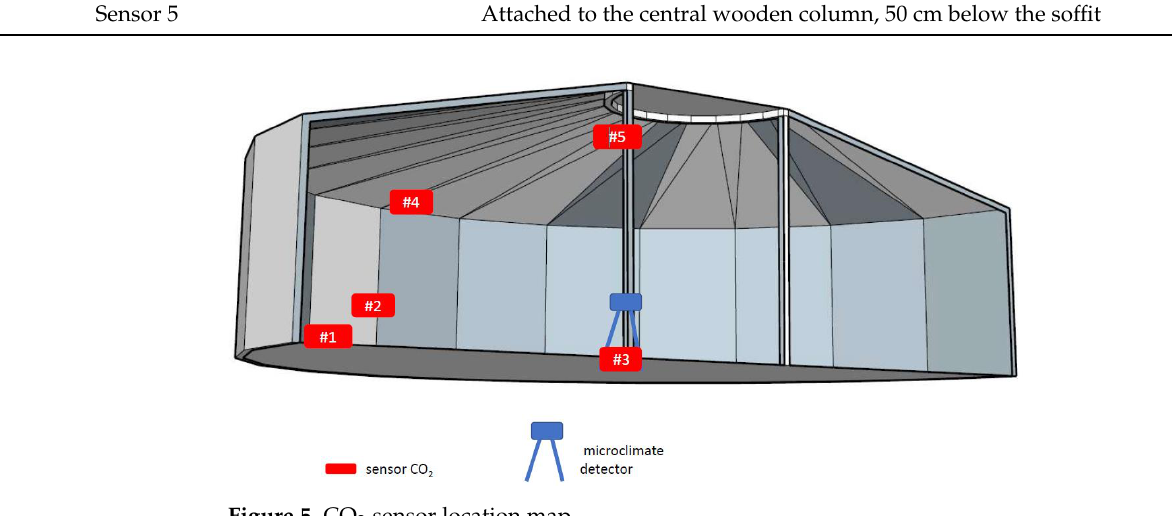
Figure 5. CO 2 sensor location map. Table 2. Description of sensors’ locations.